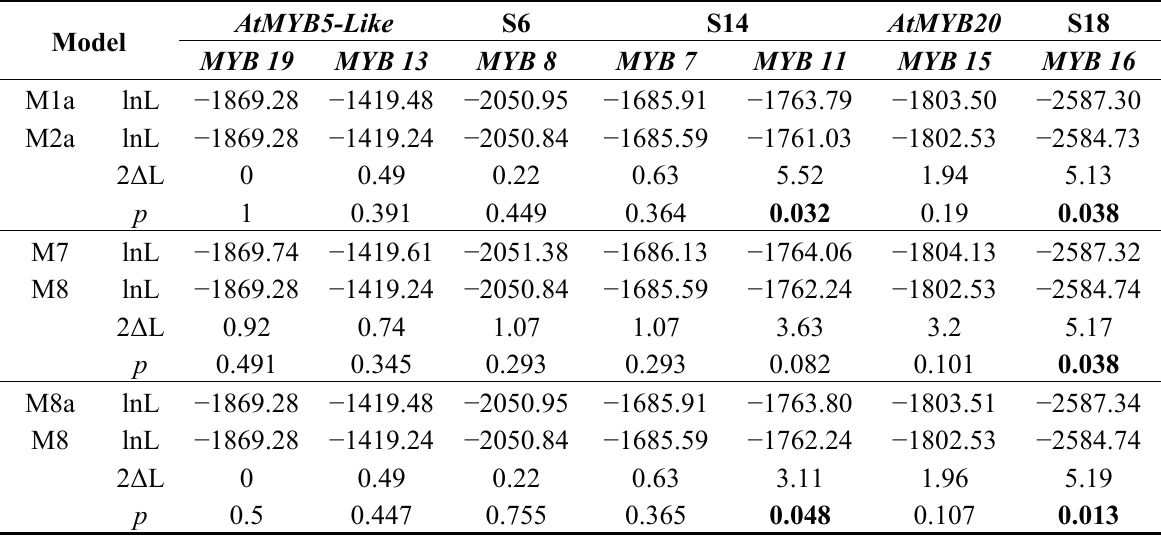
Table 4. Likelihood ratio tests for the site model analyses in Scutellaria R2R3-MYB genes. Subgroups of AtMYB family defined by Kranz et al. (1998) was provided for characterizing the MYBs of Scutellaria defined by Yuan et al.